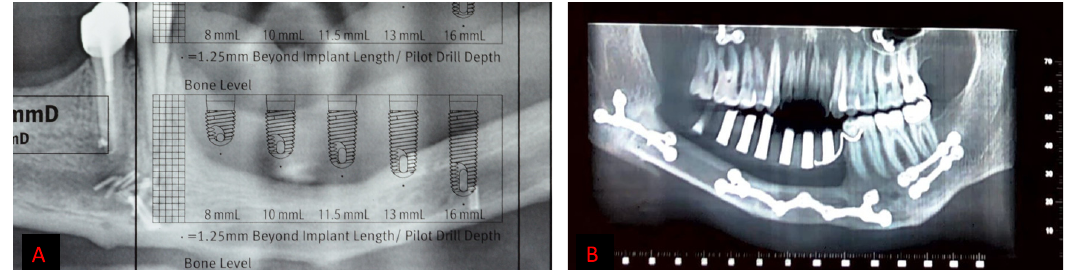
Fig. 3. Implant (cid:1) to-crown ratio superior to 1 for 3(A: patient n ° 1, B: patient n ° 2). A minimum bone gain of 10mm would optimize the supported implant prosthesis by reducing this